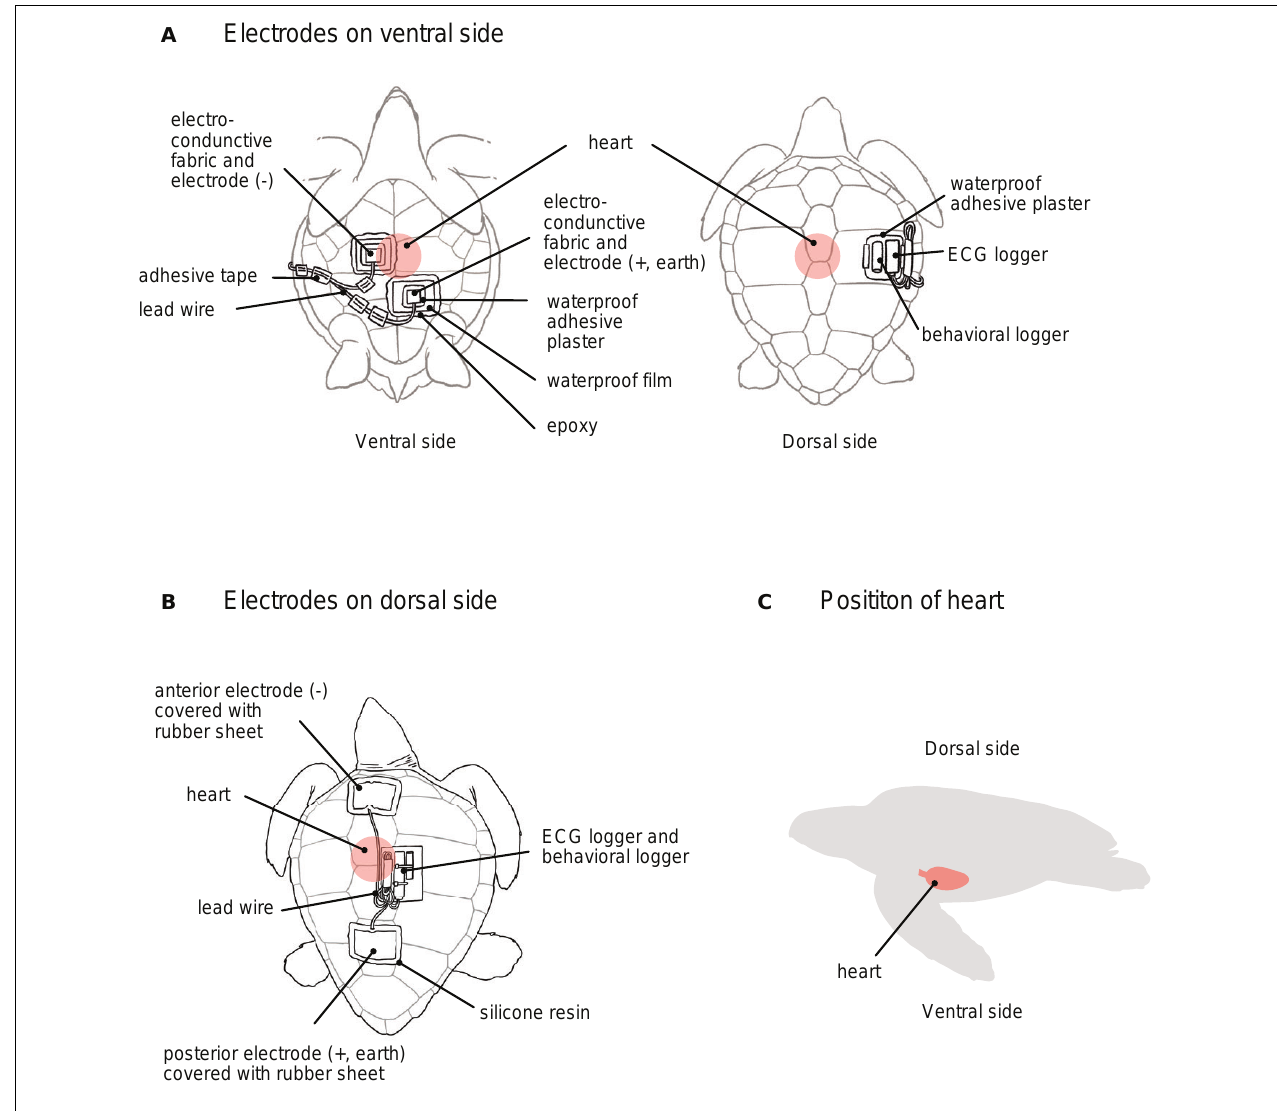
FIGURE 1 | A loggerhead turtle with electrodes and ECG and behavioral loggers attached. The method of attaching electrodes on (A) ventral side (suggested by the present study) and (B) dorsal side (developed by Sakamoto et al., 2021). (C) A position of the turtle’s heart.